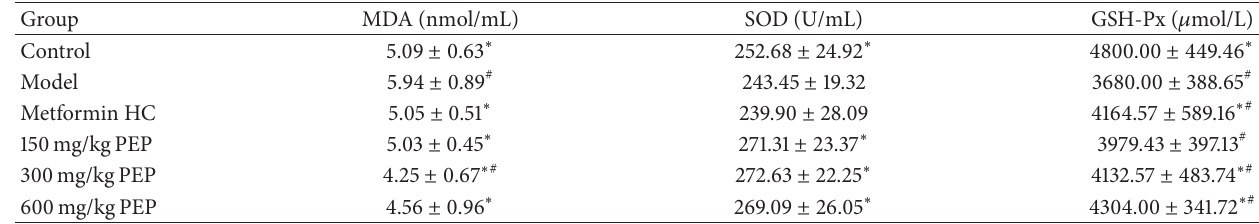
Table 4: The effect of PEP on MDA, SOD, and GSH-Px in DM